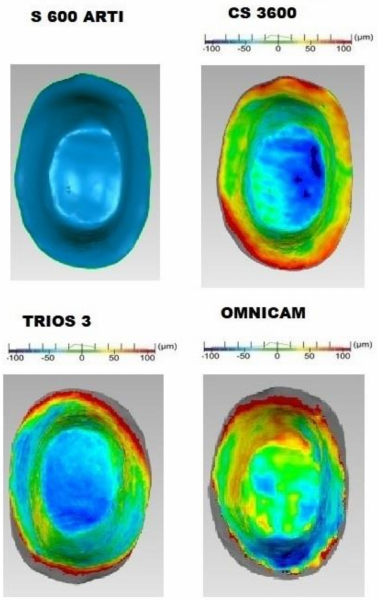
Figure 11. Comparison of the complete preparation in OVA rendering S600ARTI and 3D comparison analysis for IOS with saliva in relation to sample 3. Nominal histogram settings ± 25 microns and critical ± 100 microns.